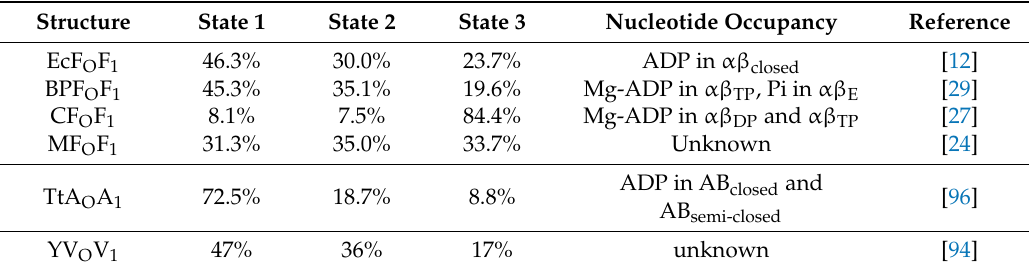
Table 1. Distribution of the three different states/rotor orientations of the F/A/V-type complexes that were found in cryo-EM studies. The F O F 1 structures were aligned according to the orientation of the central stalk in relation to the peripheral stalk. As A O A 1 and V O V 1 have two and three peripheral stalks, respectively, it is not possible to align their states with the F O F 1